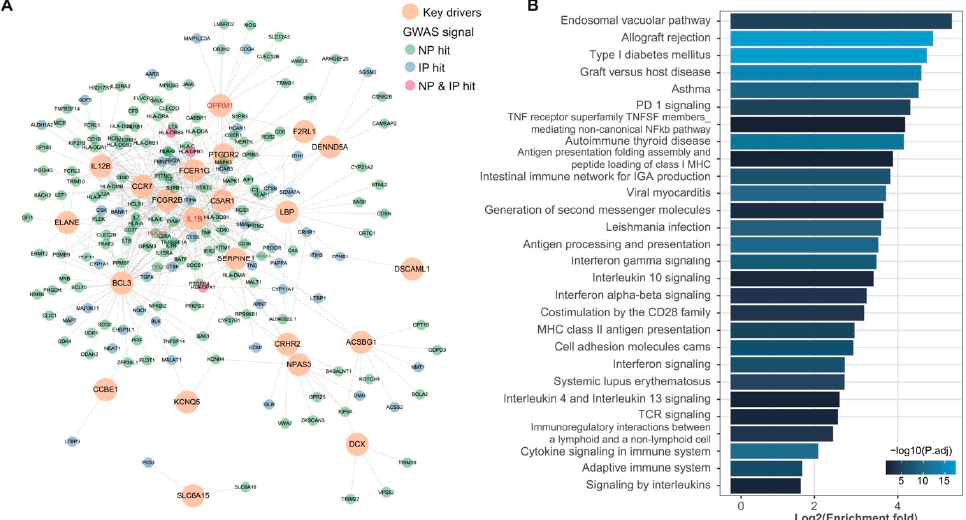
Figure 3. Key drivers and subnetworks for the NP/IP-associated modules. ( A ) Top KD subnetworks with GWAS hits ( p < 5 × 10 − 8 as reported in GWAS Catalog). KD: key driver; known pain-related genes are indicated in the red font. ( B ) Pathway analysis of the genes involved in the subnetwork in ( A ).